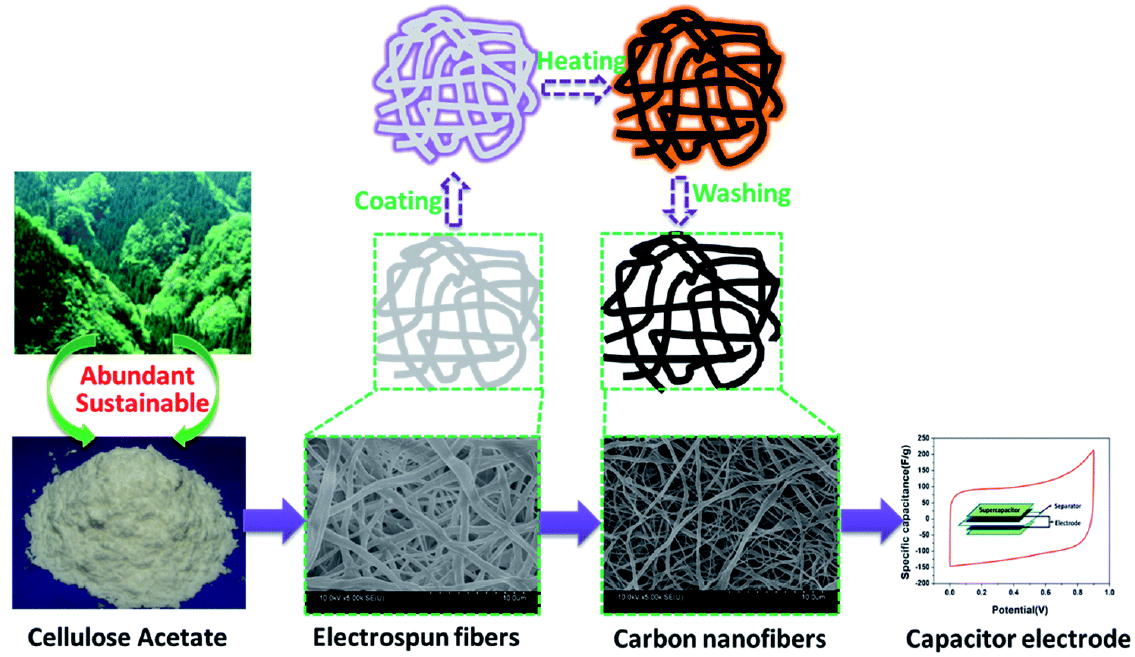
Figure 3. Synthesis route to cellulose acetate-derived carbon nanofibers. Adapted from reference